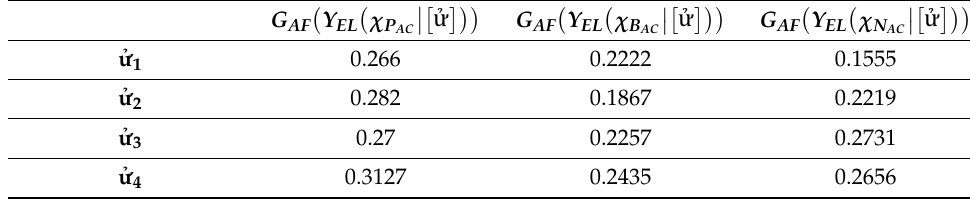
Table 5. Accuracy values from information in Table 3.